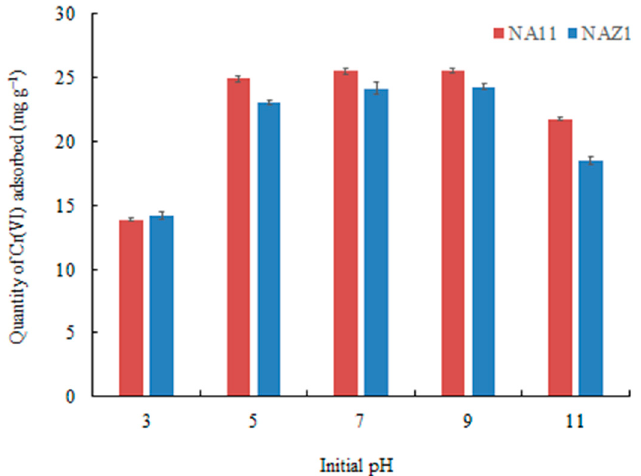
Figure 1. Effect of pH on the adsorption of Cr(VI) using NA11 and NAZ.